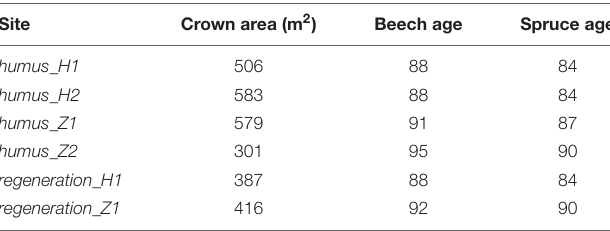
TABLE 1 | Characteristics of the experimental plots with regard to size of the beech group, age of the beech and age of the surrounding spruce stand.